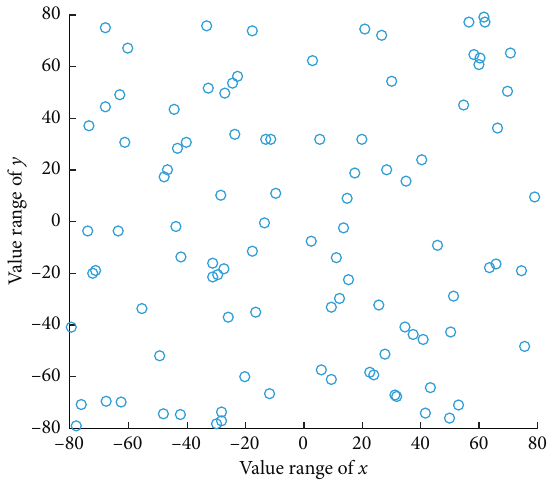
Figure 4: Initial solution generated by